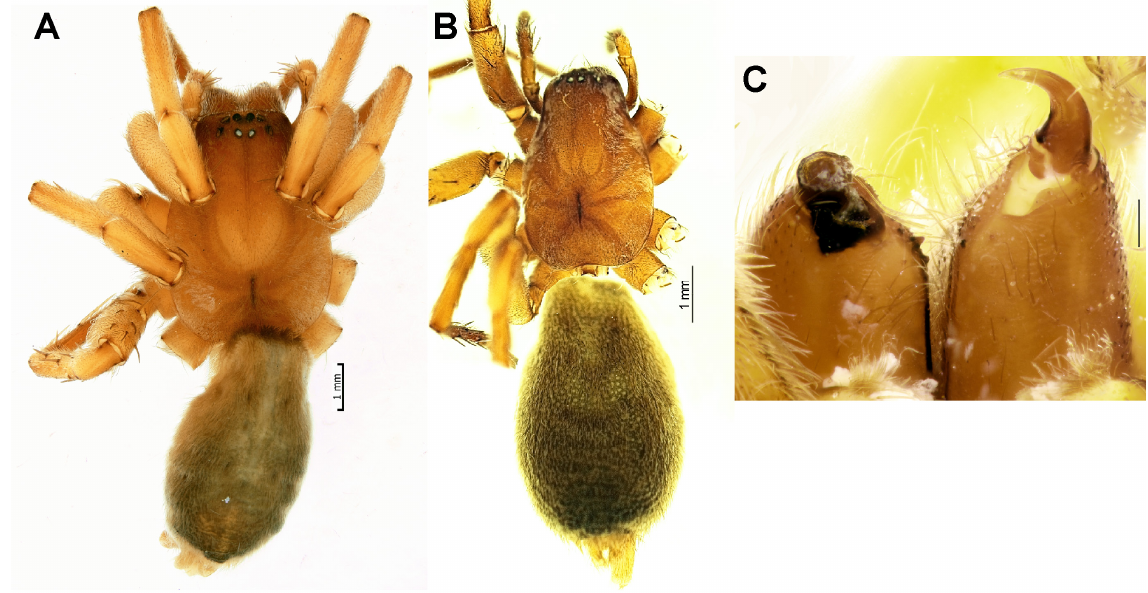
Fig. 20. Scotophaeus elburzensis sp. nov. (A, C = ♀ from Tehran Province, SMF; B = holotype, ♀, ZMMU). A–B . Habitus, dorsal view. C . Chelicerae, posterior view. Scale bars: 0.2 mm, unless stated